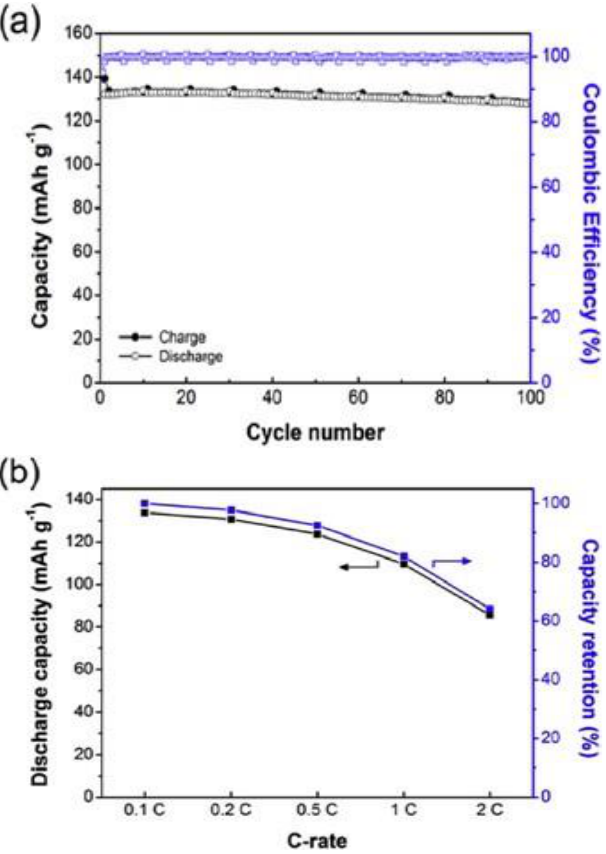
Figure 6. ( a ) Cycling performance of the solid electrolyte-based battery evaluated with a stable charge- discharge of 0.5 C at 30 ◦ C and ( b ) capacity retention values of various discharge capacities